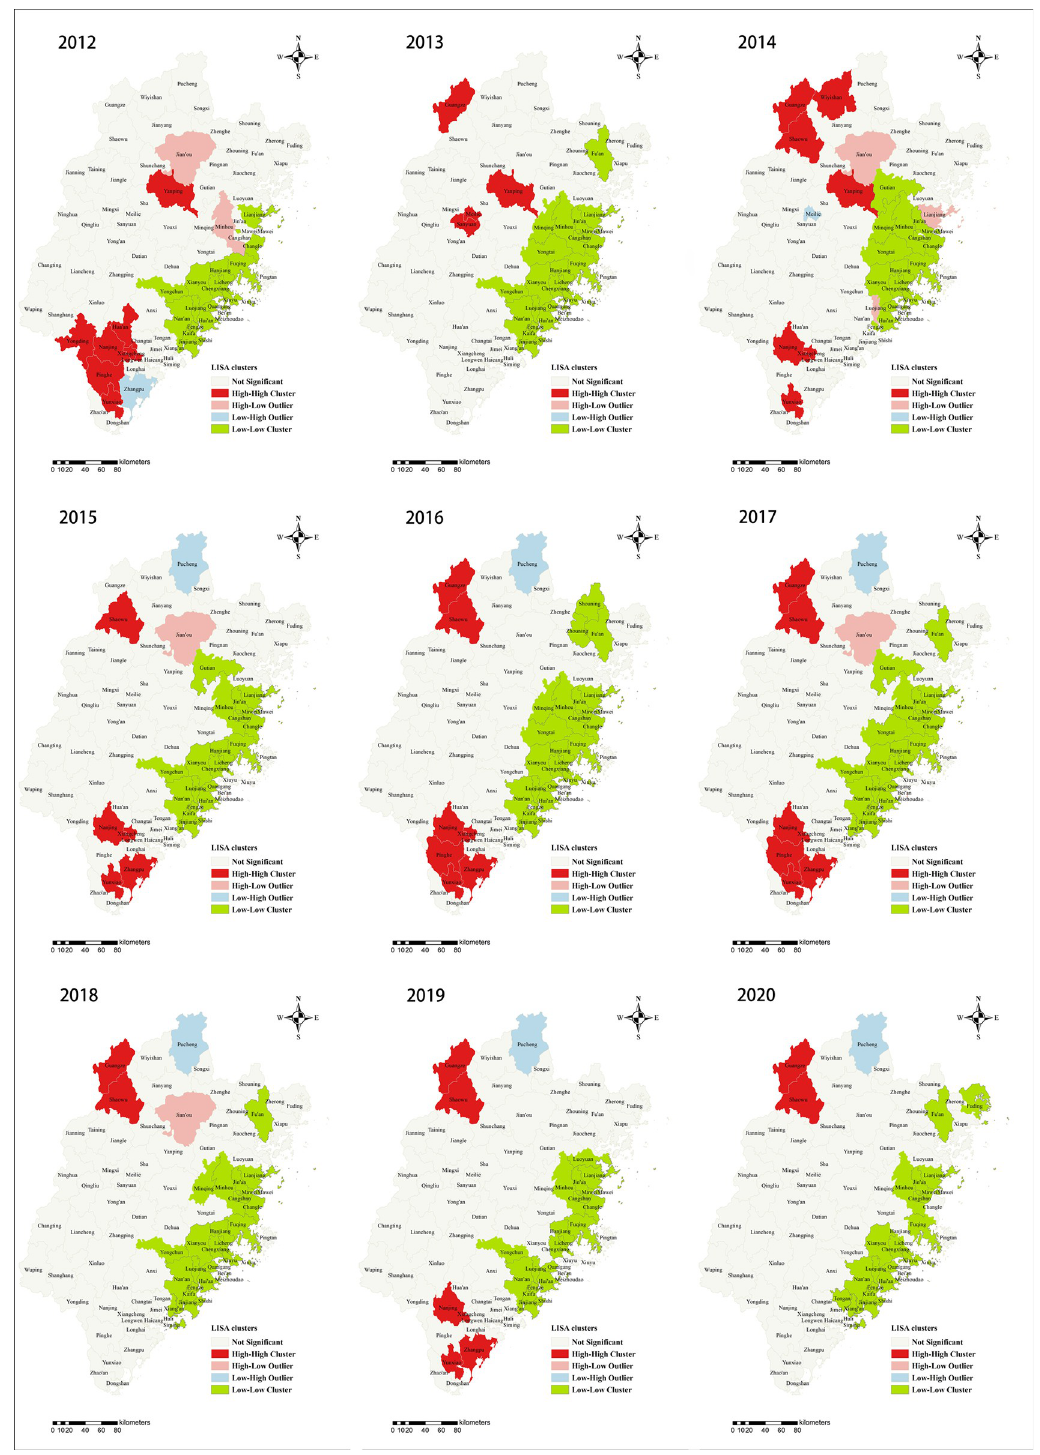
Fig 4. Yearly Local Indicators of Spatial Association (LISA) cluster maps for scrub typhus incidence in Fujian Province, 2012–2020. LISA spatial cluster map shows the center of the cluster in color. H-H indicates a statistically significant cluster of high scrub typhus incidence values; H-L represents high scrub typhus incidence values surrounded with low incidence values; L-H represents low scrub typhus incidence values surrounded with high incidence values. The base layer of the map was obtained from Resource and Environment Science and Data Center (https://www.resdc.cn/Datalist1.aspx?FieldTyepID=7,1).